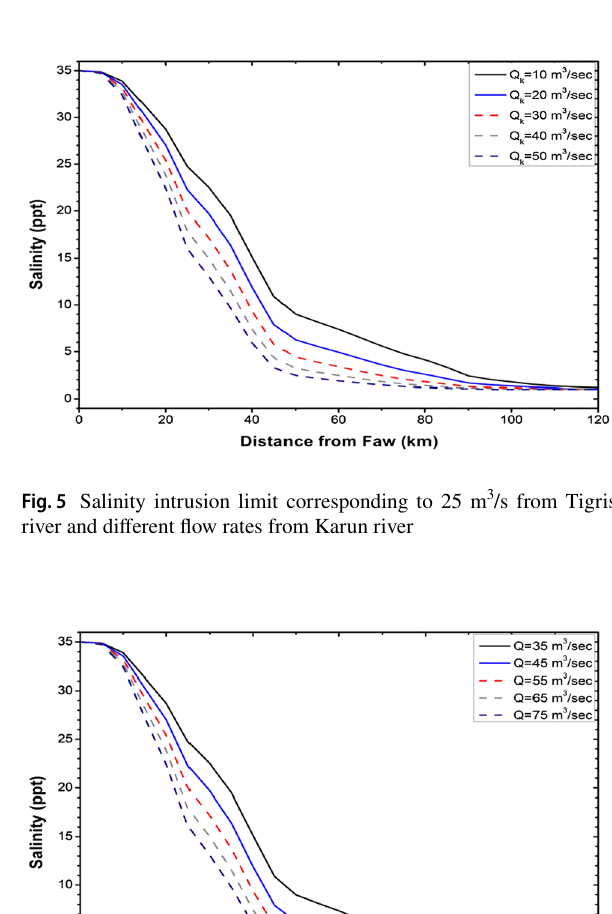
Fig. 4 Salinity intrusion limit corresponding to 50 m 3 /s from Tigris river and different flow rates from the Karun river